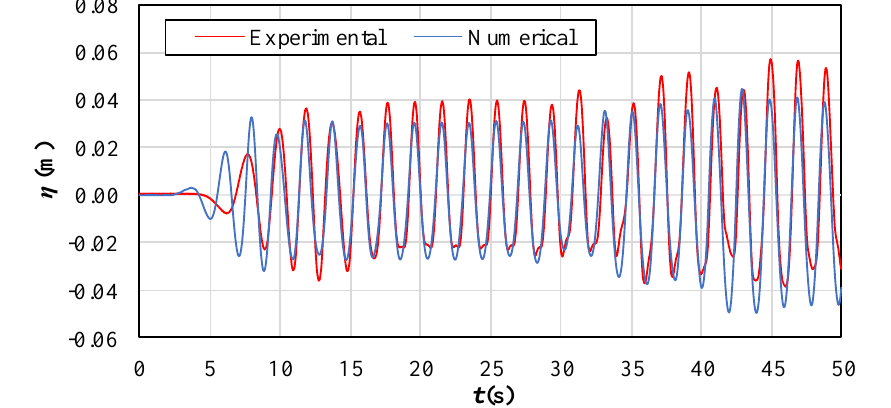
Figure 13. Comparison of experimental and numerical results. Table 8. MAE, RMSE and l ∞ norm for the free surface elevation ( η ) for the